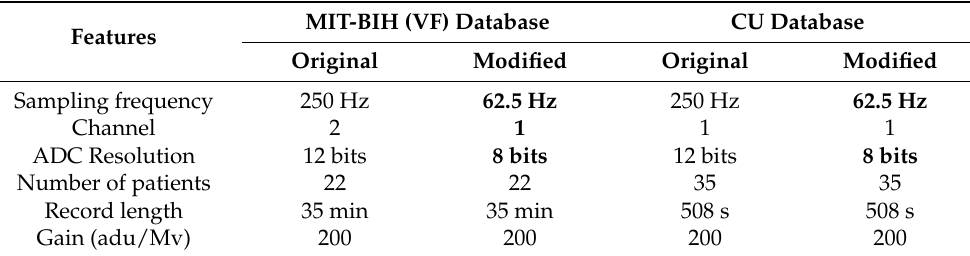
Table 2. Summary of performance for VF detection